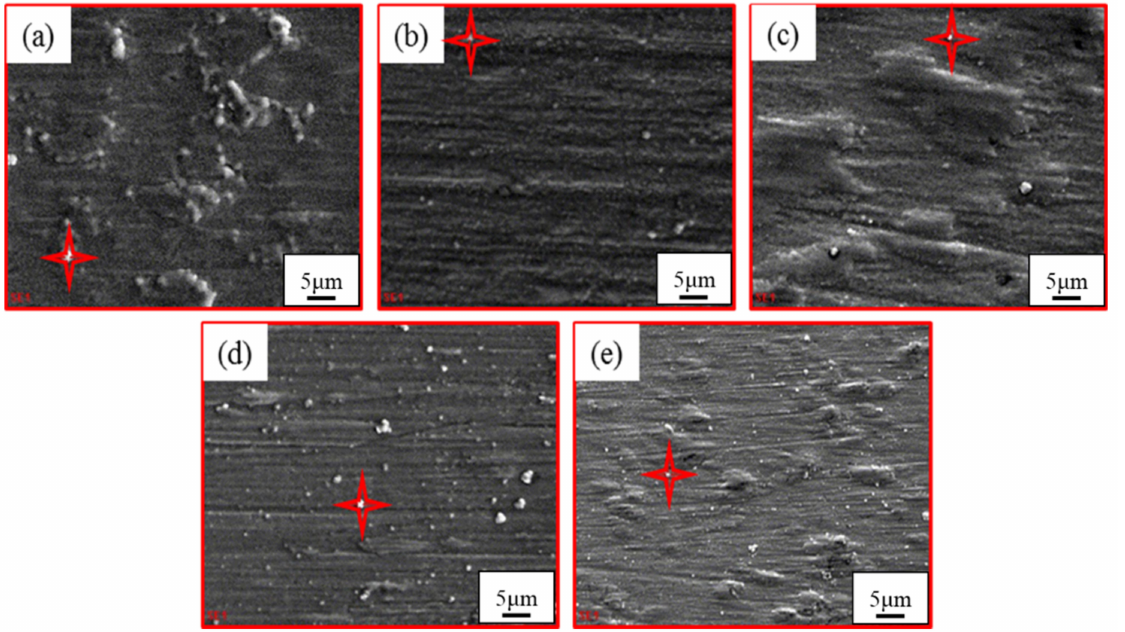
Figure 9. Location selection map of EDS spectrum analysis after TA2 low-temperature nitriding. ( a ) 0% deformed, ( b ) 20% deformed, ( c ) 40% deformed, ( d ) 60% deformed, and ( e ) 80%